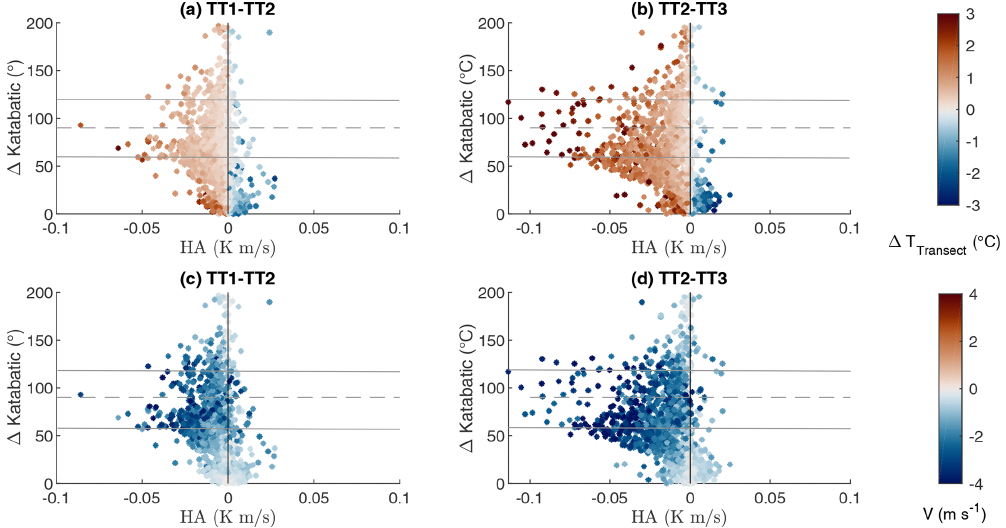
Figure 9. Horizontal advection of heat (HA) calculated between stations TT1 and TT2 (a) and TT2 and TT3 (b) from the first level above ground is plotted against the deviation from katabatic-wind direction for 5 selected days with periods of clear deviation from the domi- nant katabatic-flow direction. Colour codes indicate the measured air temperature difference between stations TT1 and TT2 and TT2 and TT3 (a, b) and the wind velocity component along the transect V (wind speed component along the transect) (c, d) . Note that all data (kata- batic and disturbed flows) are shown here. Positive values of air temperature difference indicate higher air temperatures at the station closer to the glacier margin. Negative wind velocity components indicate wind from station TT1 to TT3. The dashed line indicates the deviation of the wind direction 90 ◦ from the dominant katabatic flow, which is the orientation of the transect. The solid lines indicate the 60 ◦ wind sector that the following heat advection analysis for disturbed conditions is based on.